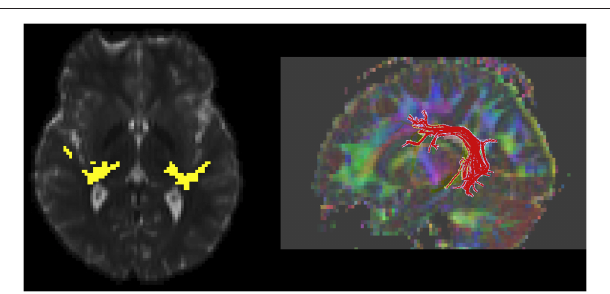
FIGURE 1 | White matter measurement regions of interest, as defined with diffusion MR tractography, are shown. An axial slice through the auditory radiation tracts shows connectivity from the auditory cortex to thalamus (yellow, left ). A 3D rendering of left-hemisphere arcuate fasciculus is shown ( right ).